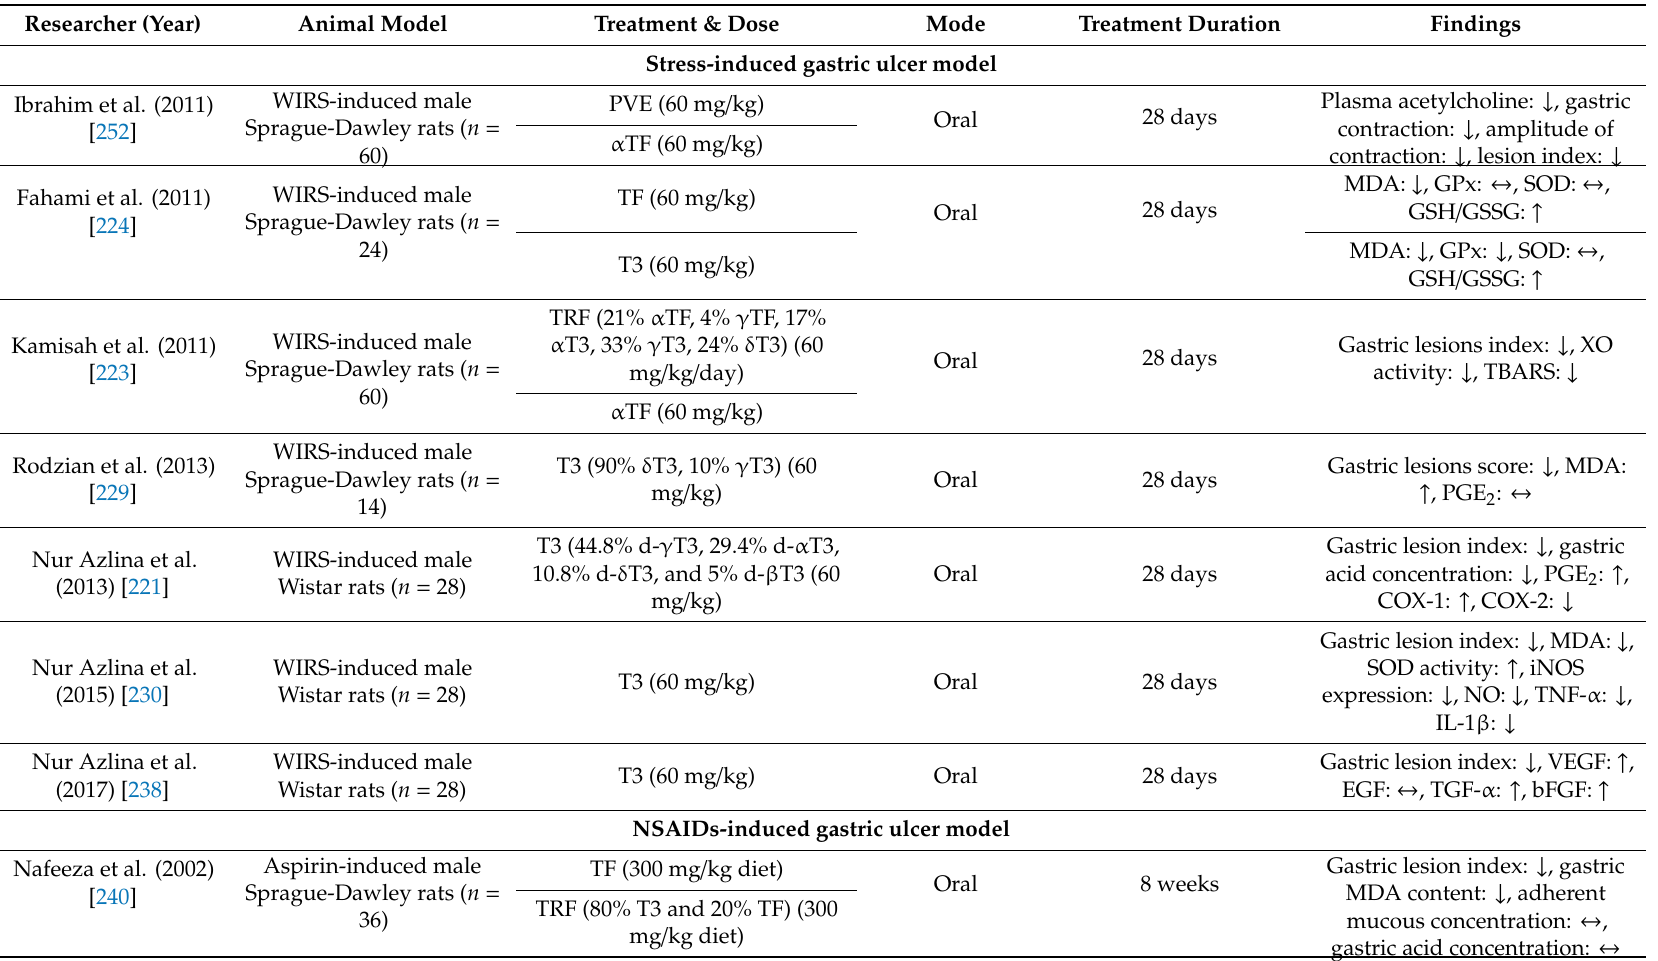
Table 11. E ff ect of T3 on peptic ulcer in